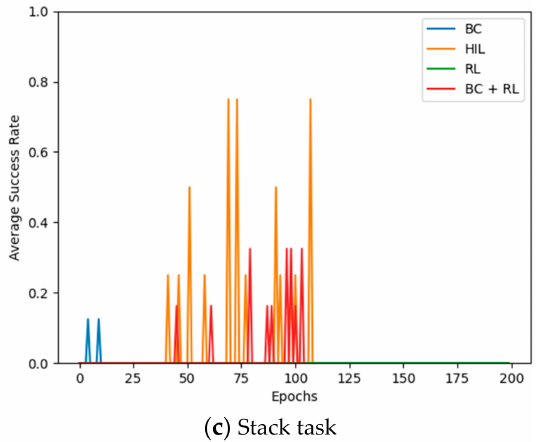
Figure 7. Comparison with conventional learning methods.